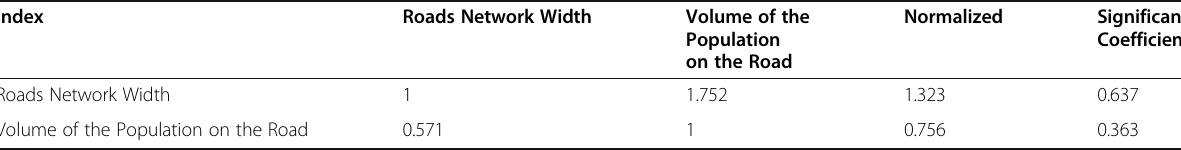
Table 6 Paired comparison matrix of the traffic indices